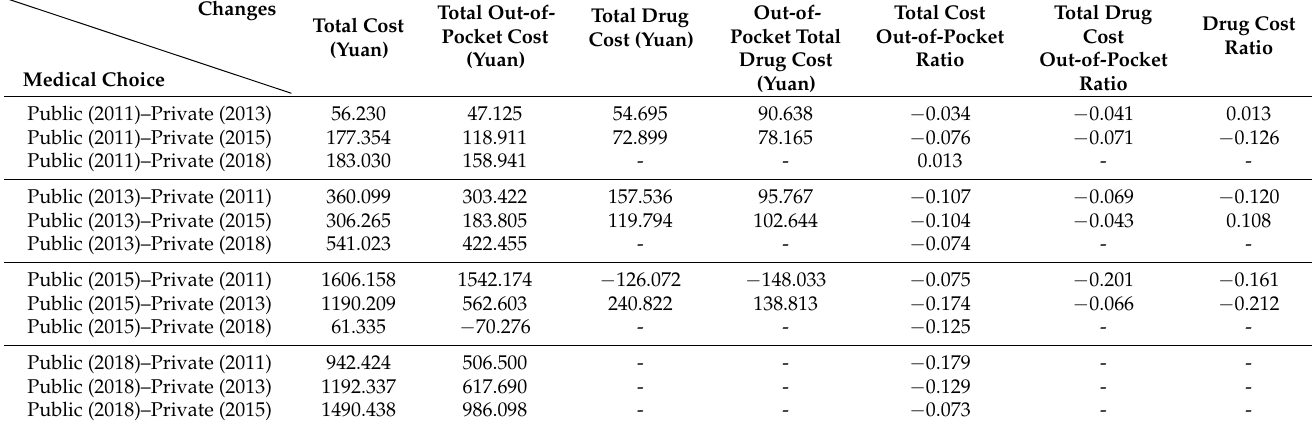
Table 3. Changes in health costs for medical choice.